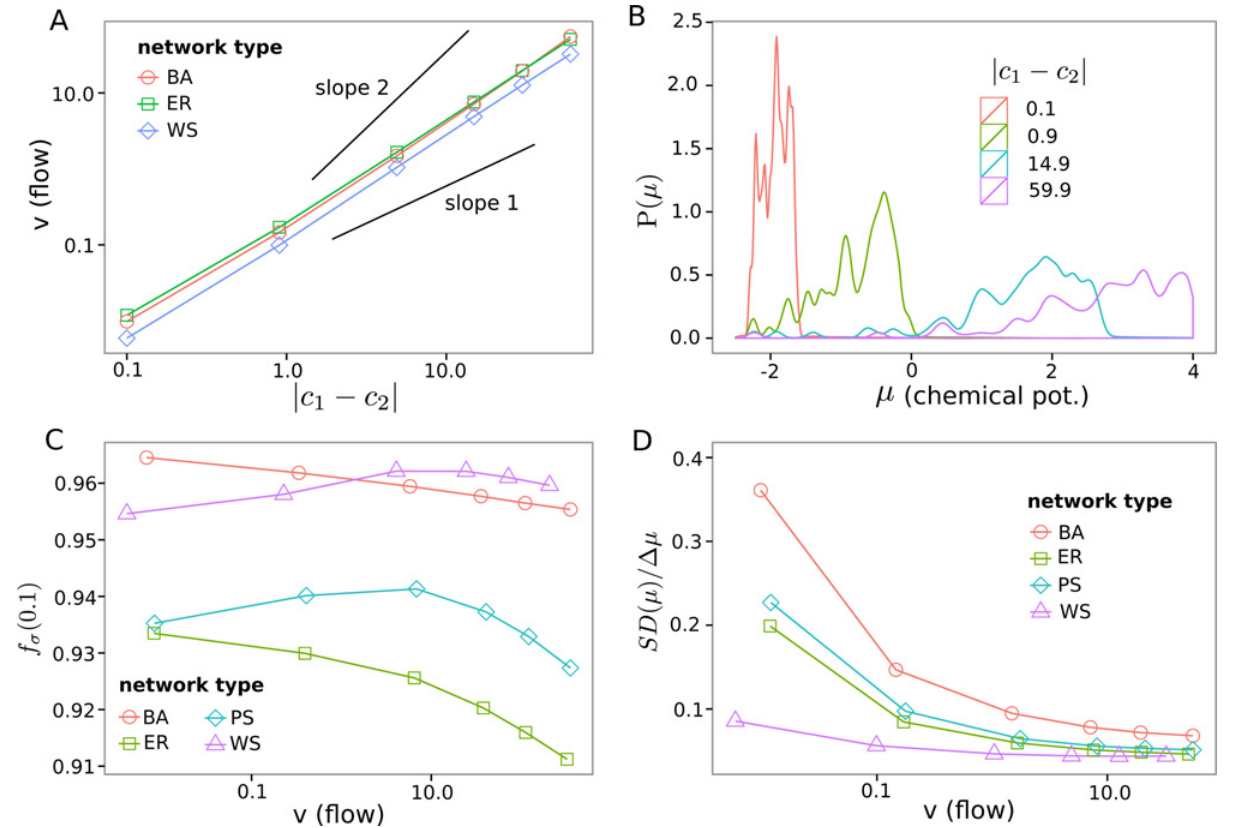
Fig 4. Varying flow through nonlinear networks. Each data point is the average of all simulations with specific boundary species concentration ( c 1 = 0.1 c 2 = 0.2 ... 60) and a shortest path between boundary species of 3. (A) Dependency of flow from concentration difference. Pan-Sinha results are not shown as they overlap with the Erd ő s-Rényi ones. (B) Distribution of species chemical potential μ i for different boundary condition strengths of BarabsiAlbert (BA) networks. (C) The fraction of dissipation in the network explained by the most dissipating 10 percent of reactions, f σ (0.1). (D) Standard deviation of chemical potentials σ μ normalized by difference between boundary species ’ potentials Δ μ = j μ b 2 − μ b 1 j shows a more localized distribution of chemical potentials for larger